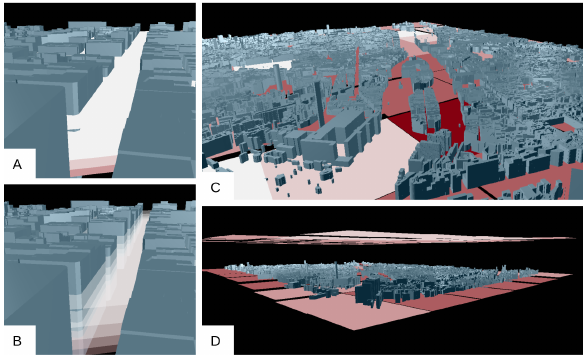
Figure 7. Visualization of air temperature data using series of 2D planes; (A) visualization at a street scale; (B) visualization at a street scale using transparency; (C) visualization of one height Figure 8. Visualization of air temperature data using a 3D point level of data at a city scale; (D) visualization of two height levels cloud; (A) visualization through series of 2D point clouds; (B) of data at a city scale. visualization through a 3D cloud of regularly spaced points; (C) visualization through a 3D cloud of randomly spaced points; (D) visualization at a city scale; (E) visualization at a street